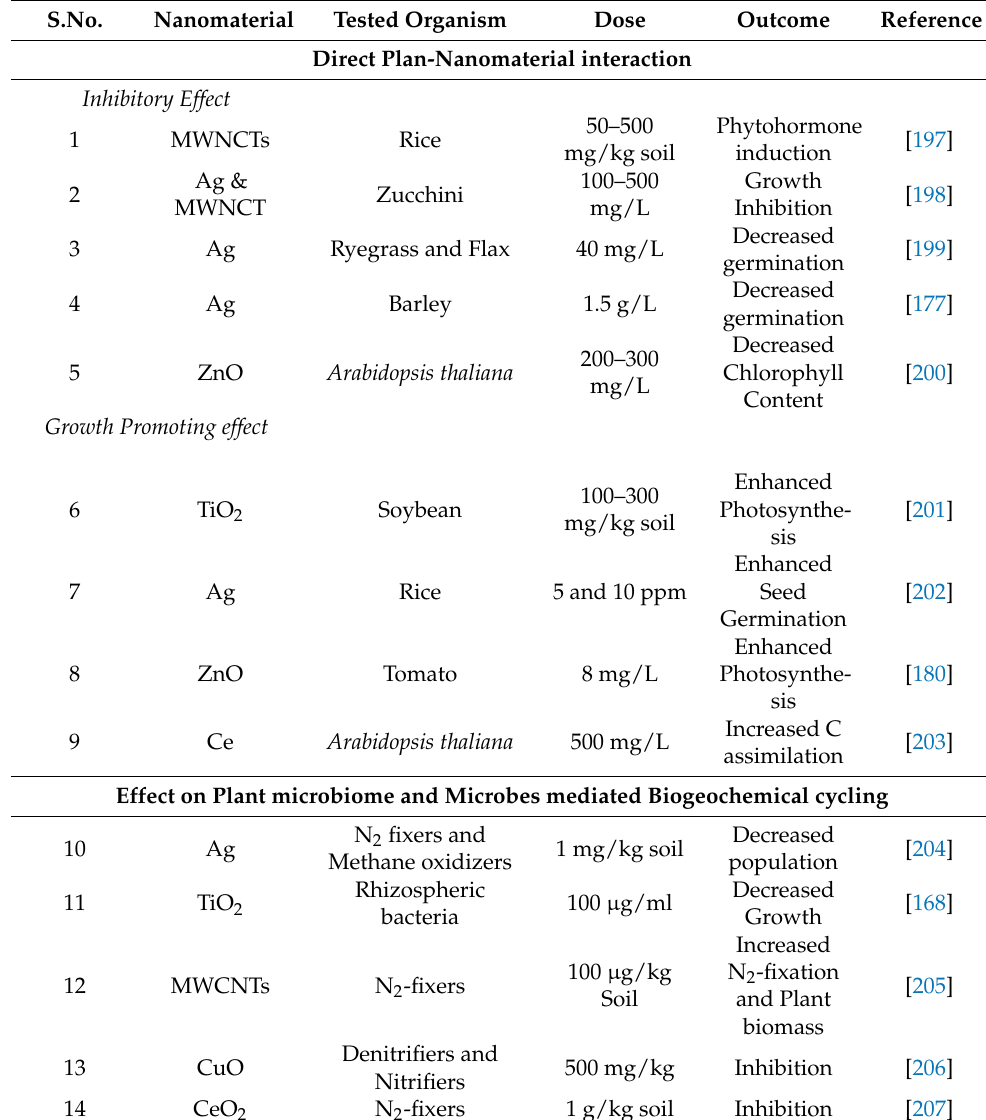
Table 1. Various consequences of the nanomaterial interactions with the plant, plant microbiome, and the plant growth promoting activities of